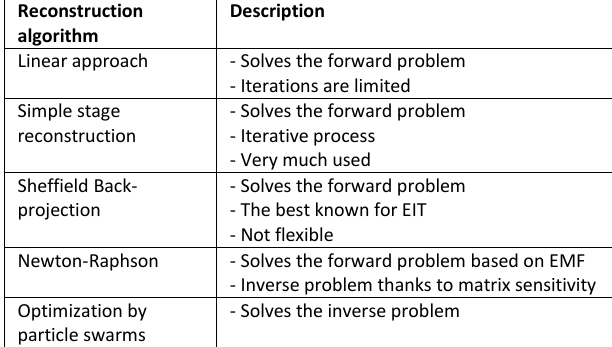
Table 3: Image reconstruction